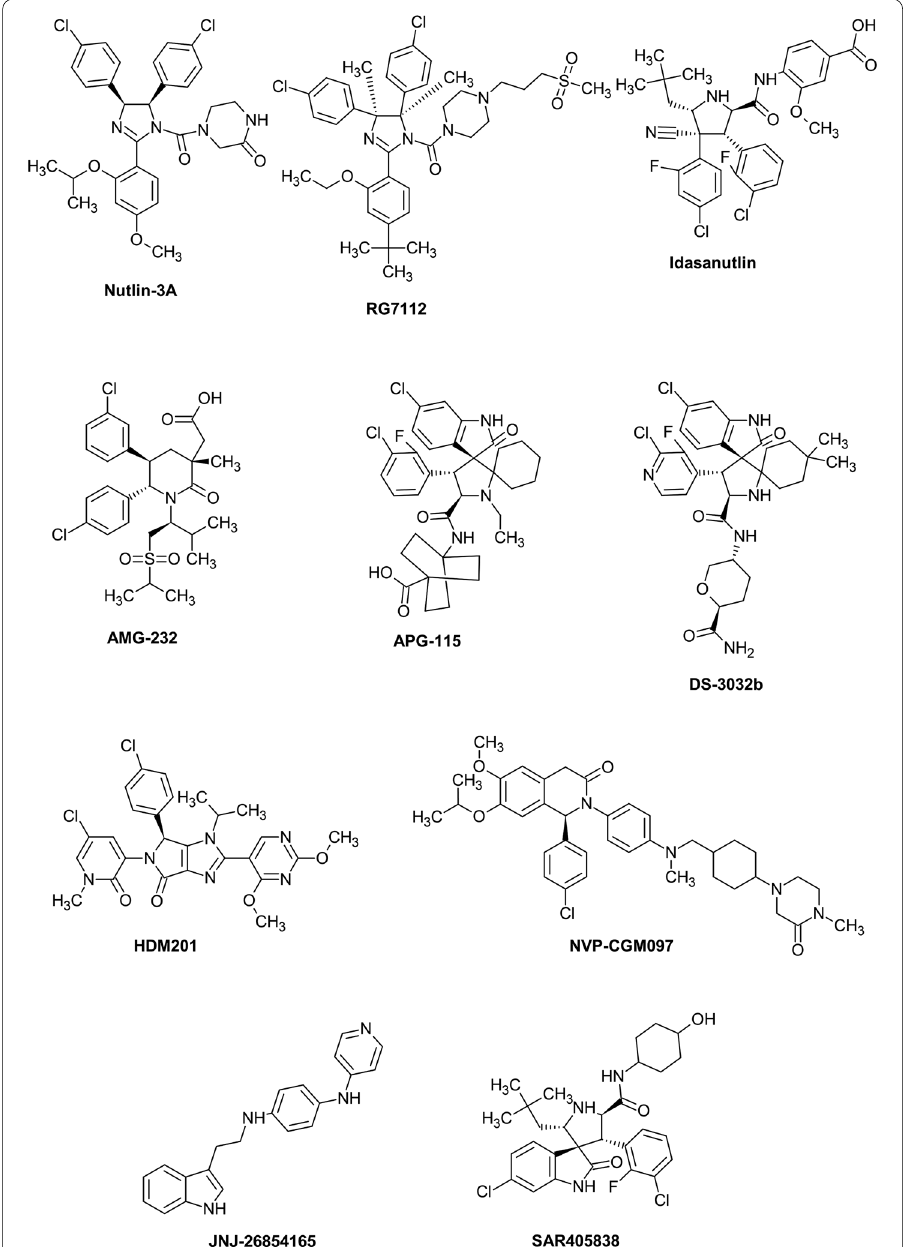
Fig. 1 Structures of MDM2 inhibitors. Available structures were obtained from PubChem database [42] with accession numbers CID 11433190; CID 57406853; CID 53358942; CID 58573469; CID 91972012; CID